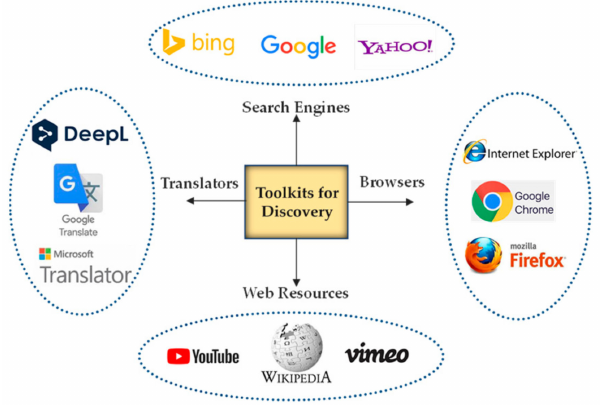
Figure 4. Sample of Toolkits for